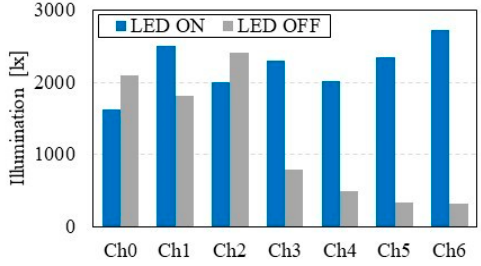
Figure 16. Experimental situation of illuminance changes due to LED light on/off.